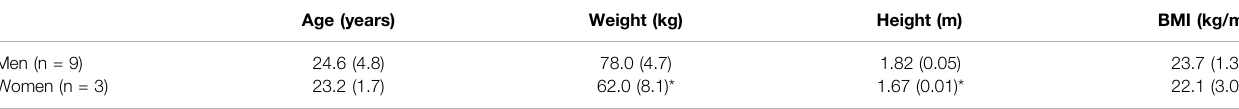
TABLE 2 | Main demographic characteristics of the included healthy volunteers.